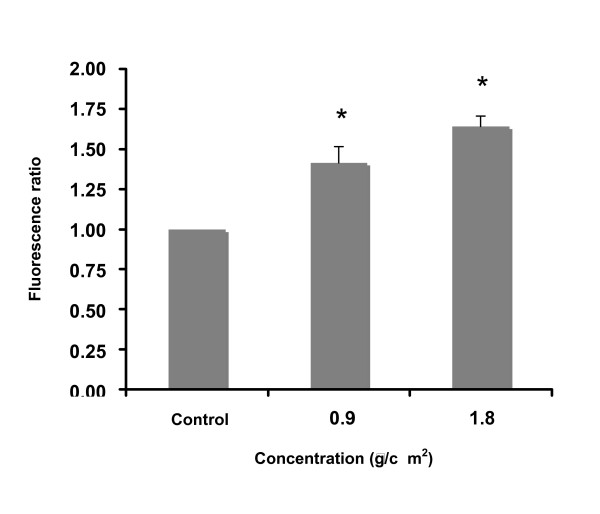
ROS detection on 16HBE14o-cells as measured by DCFH-DA fluorescence levels after exposure to Folpan 80WG® for 4 h. Data are expressed as mean fluorescence ratios ± se (fluorescence of exposed cells/fluorescence of unexposed controls) for at least 3 independent experiments. * indicates statistical significance from unexposed control (<0.0001, ANOVA followed by a Dunnett's test).